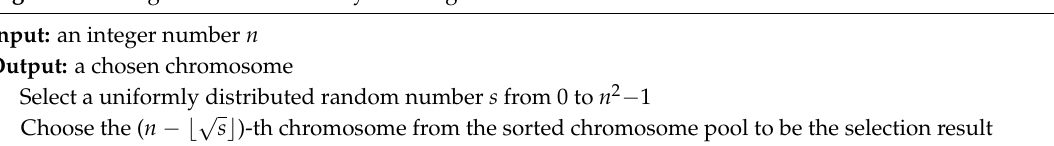
Algorithm 3. Algorithm for randomly selecting a